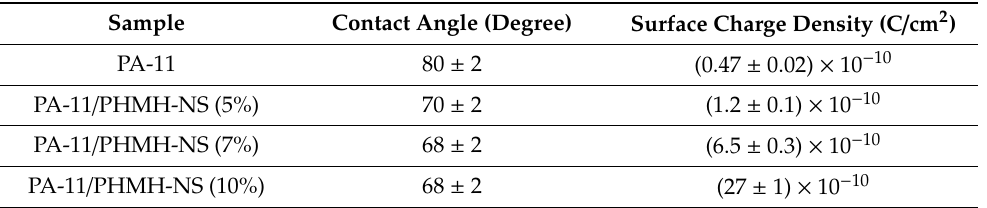
Table 1. Surface properties of PA-11/PHMG-NS films.